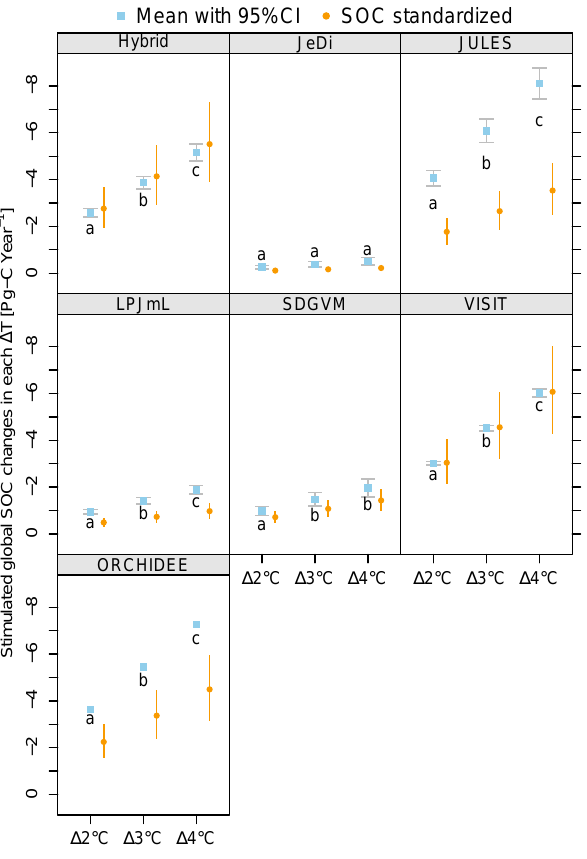
Fig. 3. Estimated global SOC changes in response to each ∆ T in each biome model based on the original global SOC stock at 2000 (blue symbols) and standardized as the empirical global SOC stock (1255 Pg C, 95 % C.I.; 891 Pg C–1657 Pg C) estimated in Todd-Brown et al. (2013). Different letters indicate no partial duplication among 95 % CI for each biome model (Table 2). Fig. 4. Maps of SOC changes by 2099 from 2000 and cumulative density function (CDF) in each biome model in HadGEM RCP8.5. In the plot of CDF, red lines indicate 2.5 and 97.5 percentiles of SOC changes.